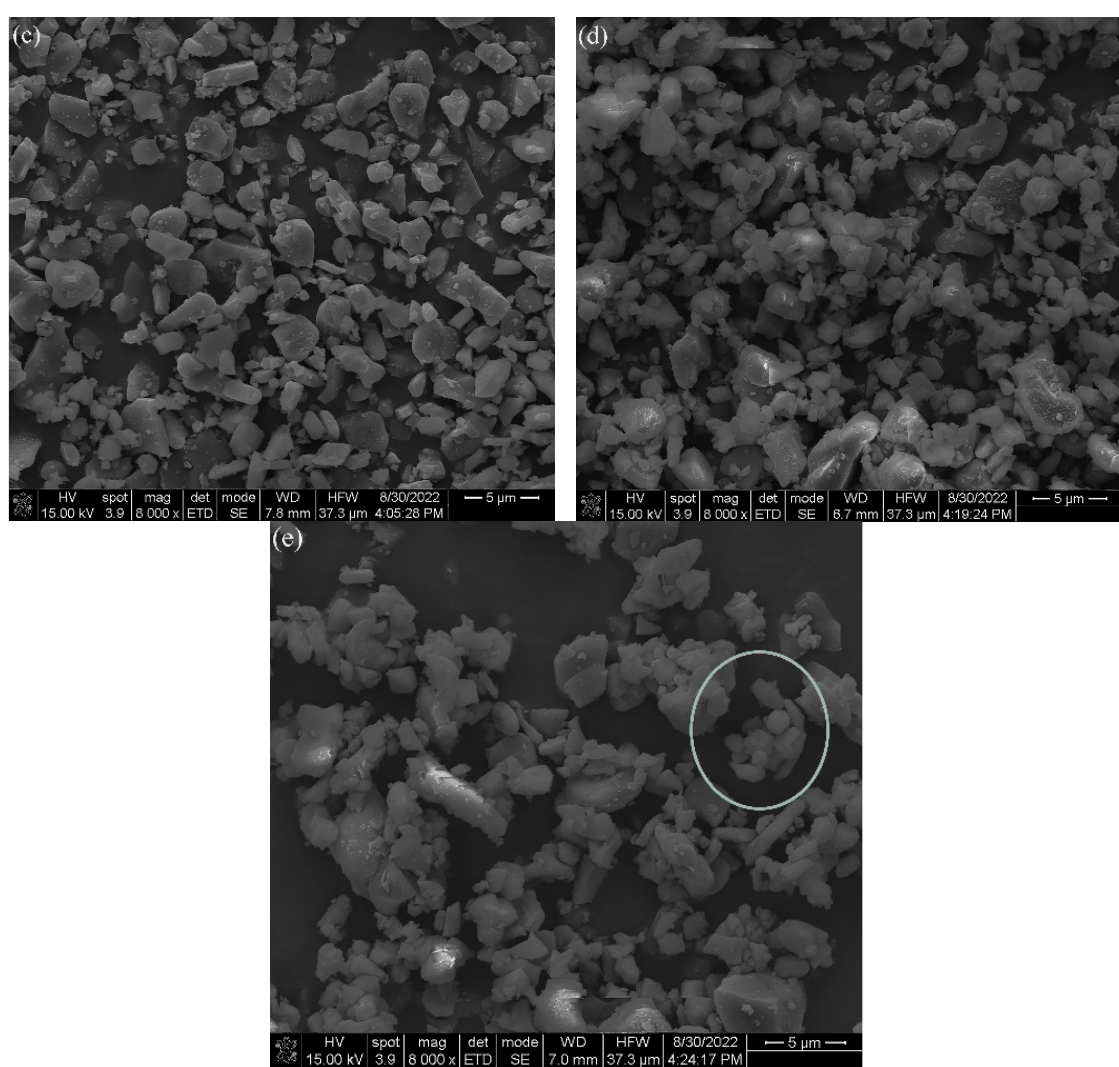
Figure 4. SEM images of Al 2 O 3 powder after different times of DBDPM: ( a ) 1 h; ( b ) 2 h; ( c ) 3 h; ( d ) 4 h; and ( e ) 5 h.